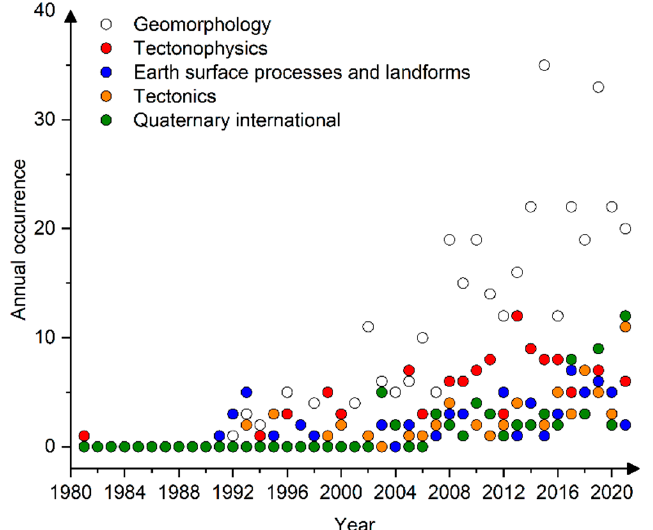
Figure 4. Dynamic analysis of the top 10 journals in tectonic geomorphology research from 1981 to 2021.